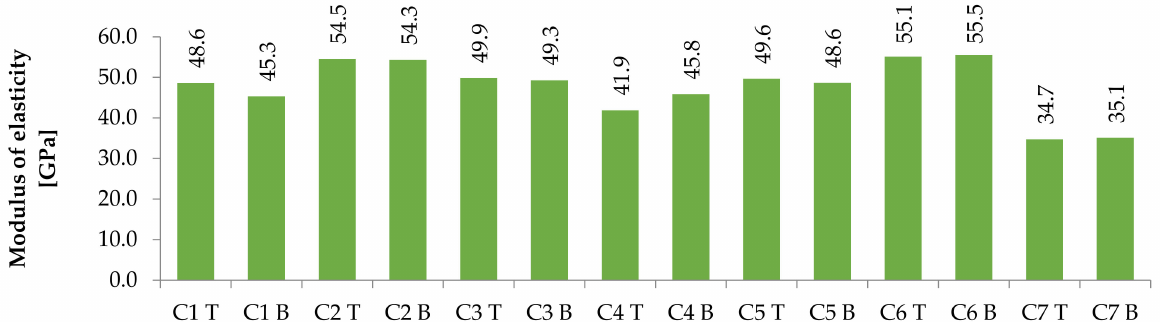
Figure 5. Modulus of elasticity results at the top (T) and bottom (B) parts of columns for individual concrete mixtures.